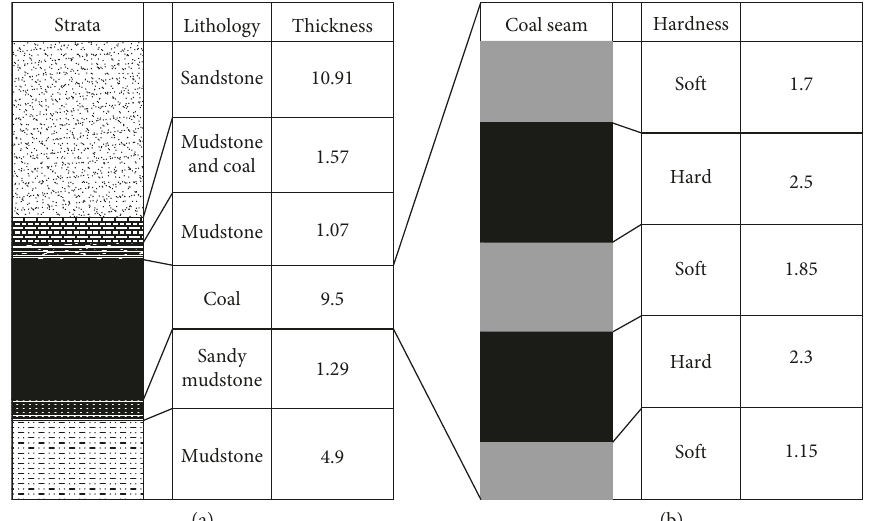
Figure 10: (a) Coal seam comprehensive column shape at N101 fully mechanized caving face in Qinyuan coal mine. (b) Top coal